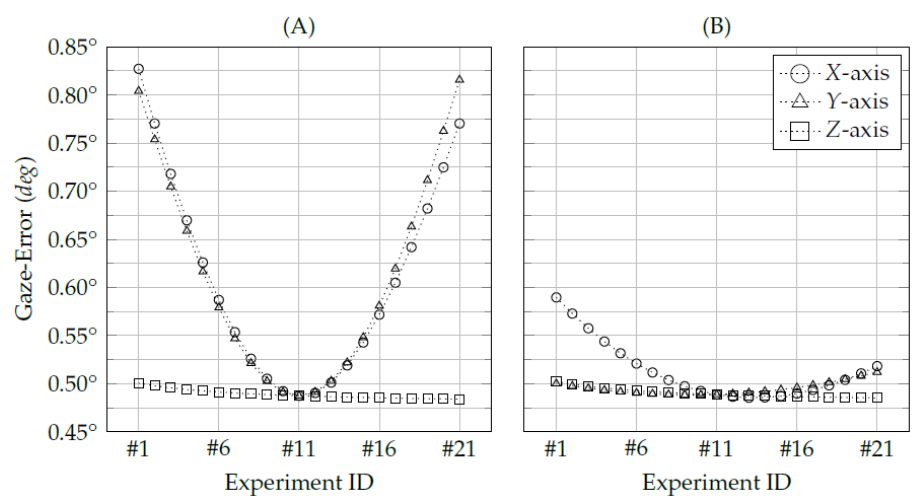
Figure 8. Accuracy as a function of the eye-camera location. The eye-camera has moved to 21 different locations (fixed steps) between the pre-defined ranges, i.e., x -axis (from − 200 mm to 200 mm), on y -axis (from 50 mm to 350 mm), and z -axis (0 mm to 400 mm). ( A ) the accuracy of the traditional homography gaze estimation method, and ( B ) the accuracy of the traditional second-order polynomial gaze estimation